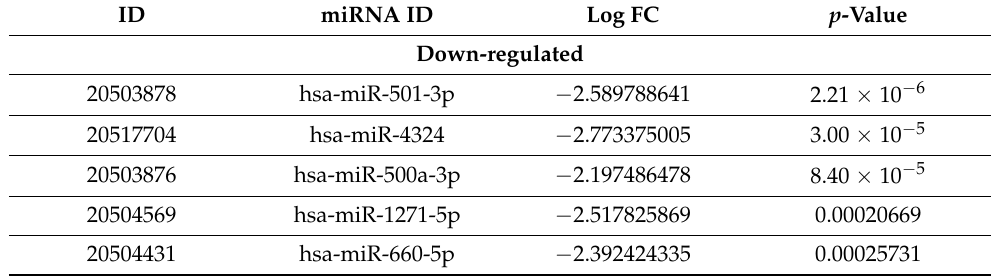
Table 1. The top five upregulated and top five downregulated miRNAs based on the logFc and p - value.